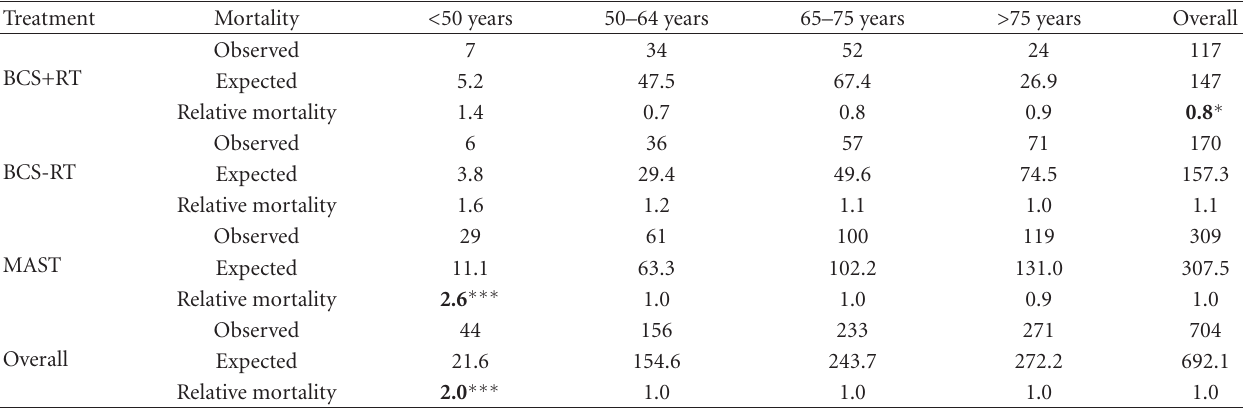
Table 3: Mortality (10 years) of the surgically treated patients with DCIS as compared to the general population according to age, stratified by